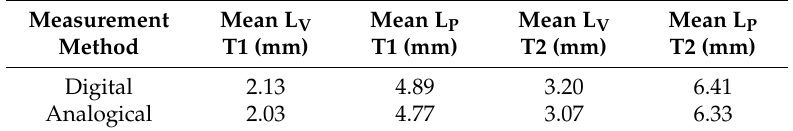
Table 4. Mean values of maximum Vestibular (L V ) and Palatal (L P ) length at T1 (2 months) and T2 (4 months) calculated with digital and analogical methods.